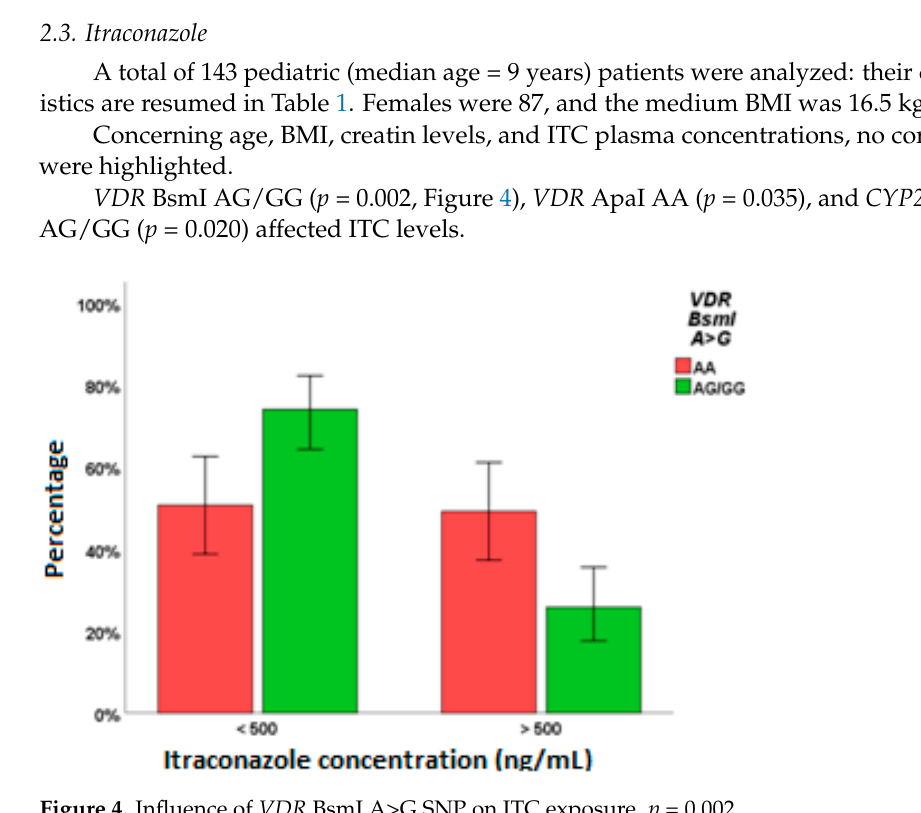
Figure 4. Influence of VDR BsmI A>G SNP on ITC exposure. p = 0.002. In the regression analysis evaluating concentration higher than the efficacy cut-off value of 500 ng/mL (Table 4A), VDR BsmI AG/GG was the only predictor. On the other hand, the female sex, CYP27B1 − 1260 GT/TT and VDR TaqI CC remained in the final regression model related to the toxicity-associated cut-off value of 1000 ng/mL (Table 4B). Table 4. Logistic regression analysis: factors able to predict itraconazole plasma concentrations over efficacy cut-off limits (>500 ng/mL) ( A ) and toxicity cut-off limits (>1000 ng/mL) ( B ). Bold characters represent statistically significant values. NC: not statistically comparable since one group is missing. Itraconazole Plasma Concentrations > 500 ng/mL (A) Itraconazole Plasma Concentrations > 1000 ng/mL (B) Univariate Multivariate Univariate Multivariate